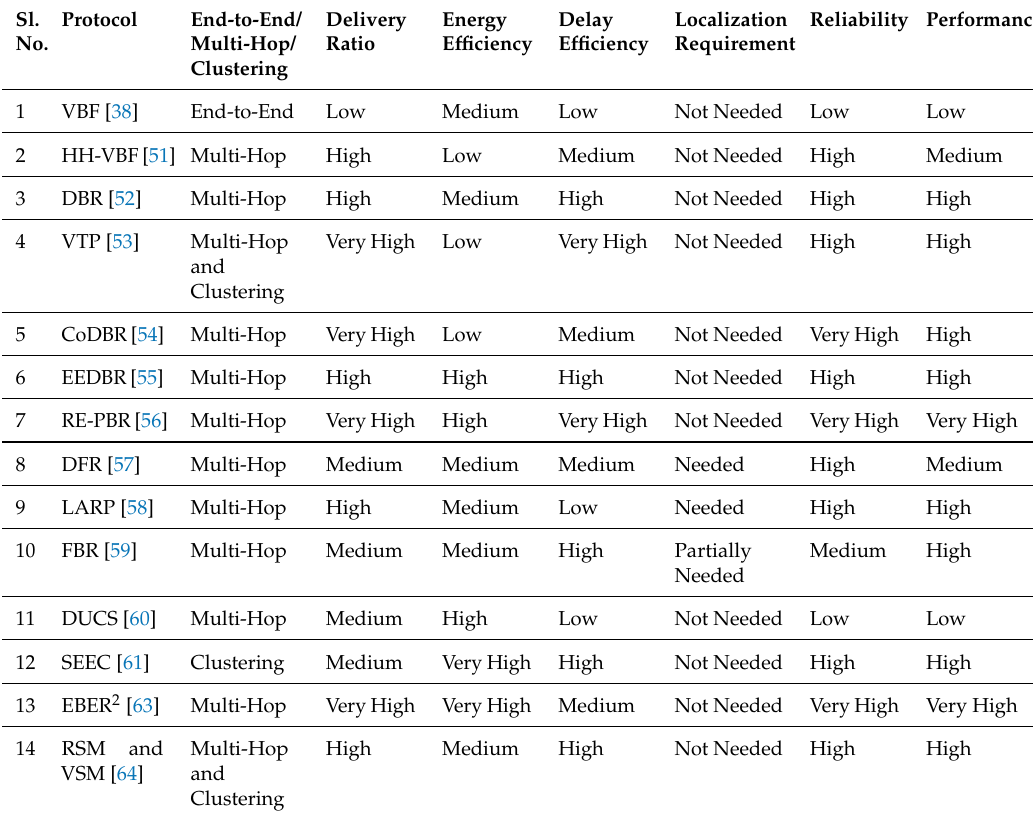
Table 4. Evaluation of the Routing